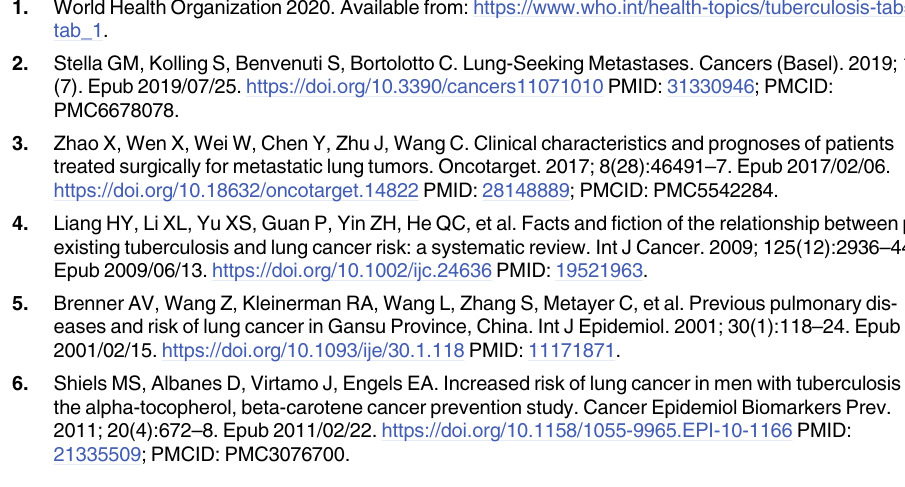
S1 Table. Abbreviation and ICD-9-CM